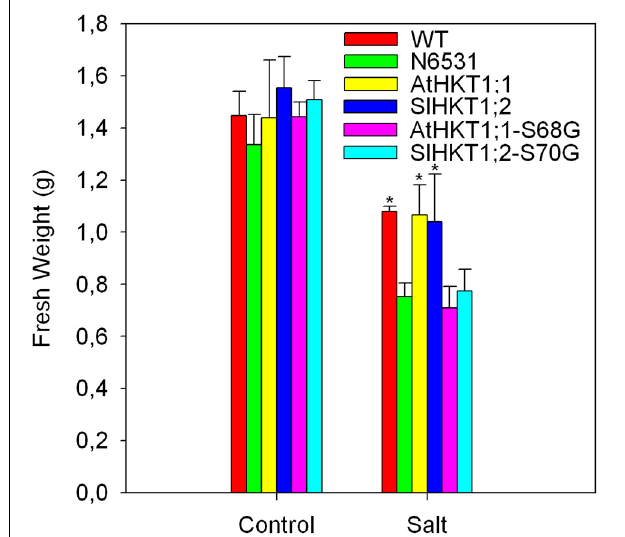
FIGURE 4 | Presence of 100mM NaCl in the irrigation water during 2 weeks significantly reduced the fresh weight of transformed, WT and athkt1;1 (N6531) Arabidopsis plants in comparison to control plants irrigated with water not supplemented with NaCl. Different inhibitions on the fresh weight production are observed amongst different transformed plant lines. Arabidopsis WT and athkt1;1 plants were used as positive and negative controls, respectively. Treatment: p < 0 . 05; plant lines: p < 0 . 05; treatment ∗ plant lines (n.s.); Two-Way ANOVA. Values indicate the means ± SE of three to seven biological